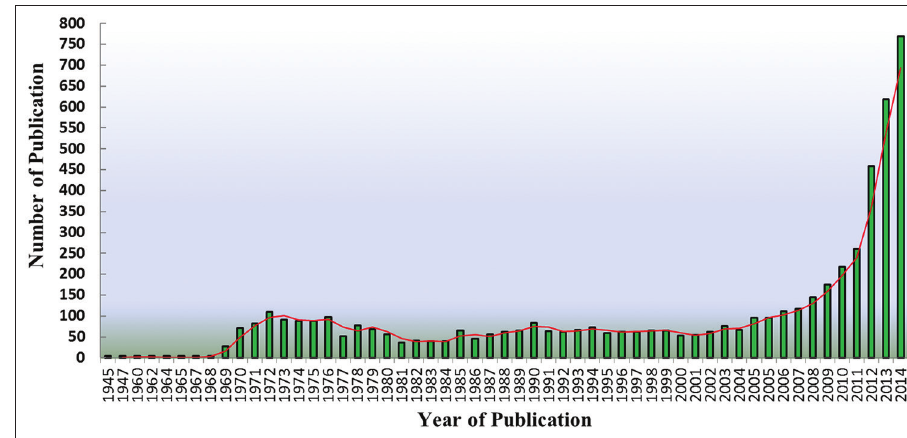
Figure-1: Temporal trend of publication on mobile health Table-1: Top 10 productive countries with publication on topics of Mobile Health. Country